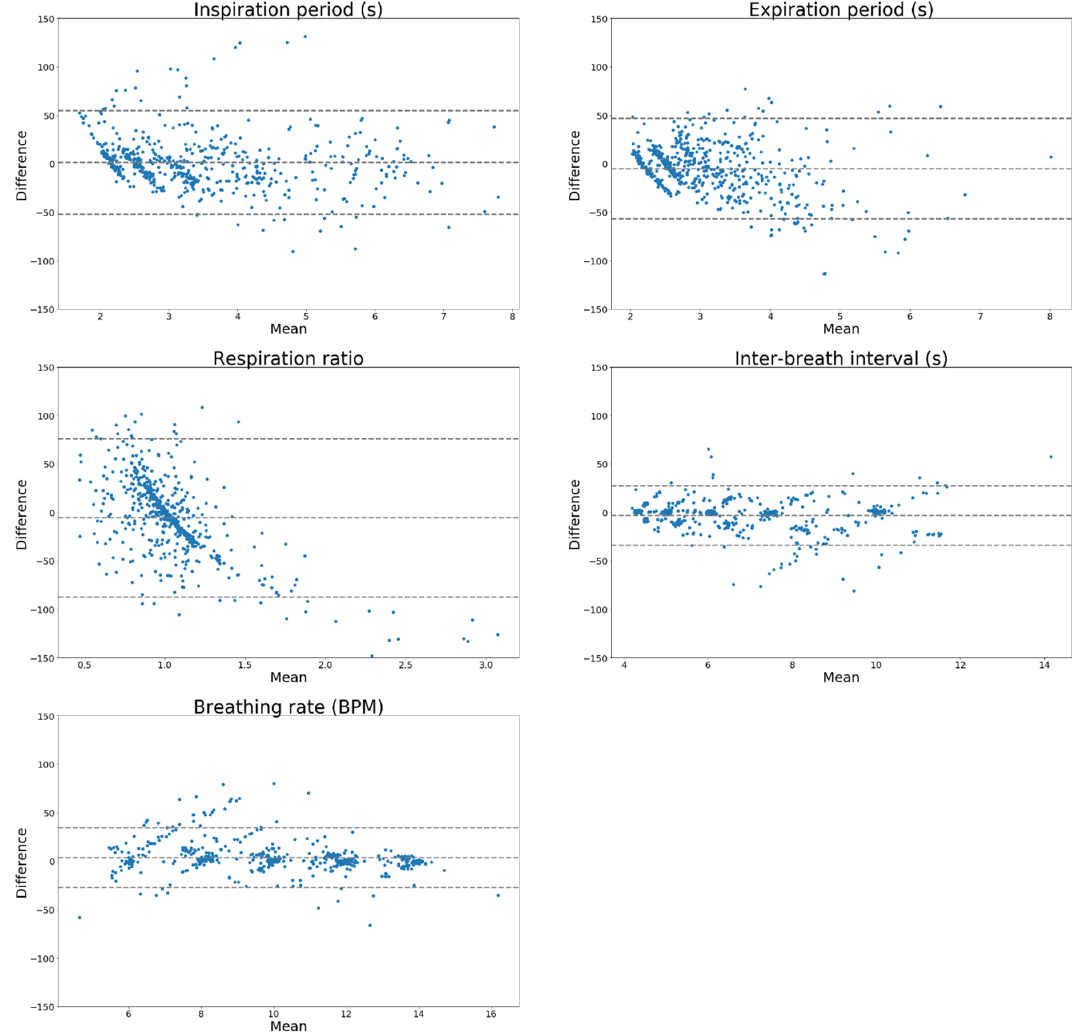
ff erences for U-Net